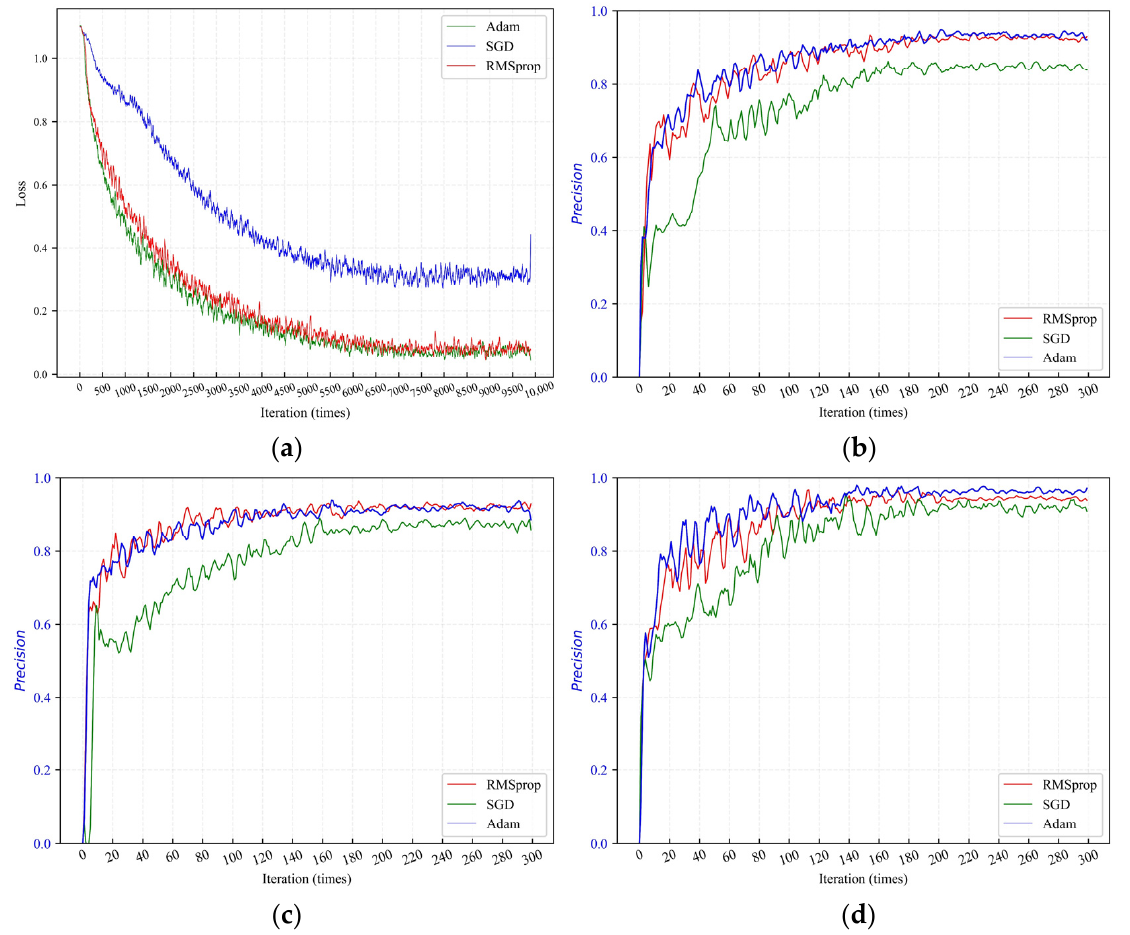
Figure 19. ( a ) Training loss of MobileNetV2 under three optimizers; ( b ) results of metamorphic rock under three optimizers; ( c ) results of sedimentary rock; and ( d ) results of volcanic rock. Figure 20 indicates the ability of the classification models. The exact evaluation index value of the models with the application of the three optimizers could be calculated using Equations (7)–(9), and the results are shown in Table 7. The RMSprop optimizer achieved 93% accuracy for both metamorphic and sedimentary rocks. The highest precision of volcanic classification was the model using Adam, which achieved 97%